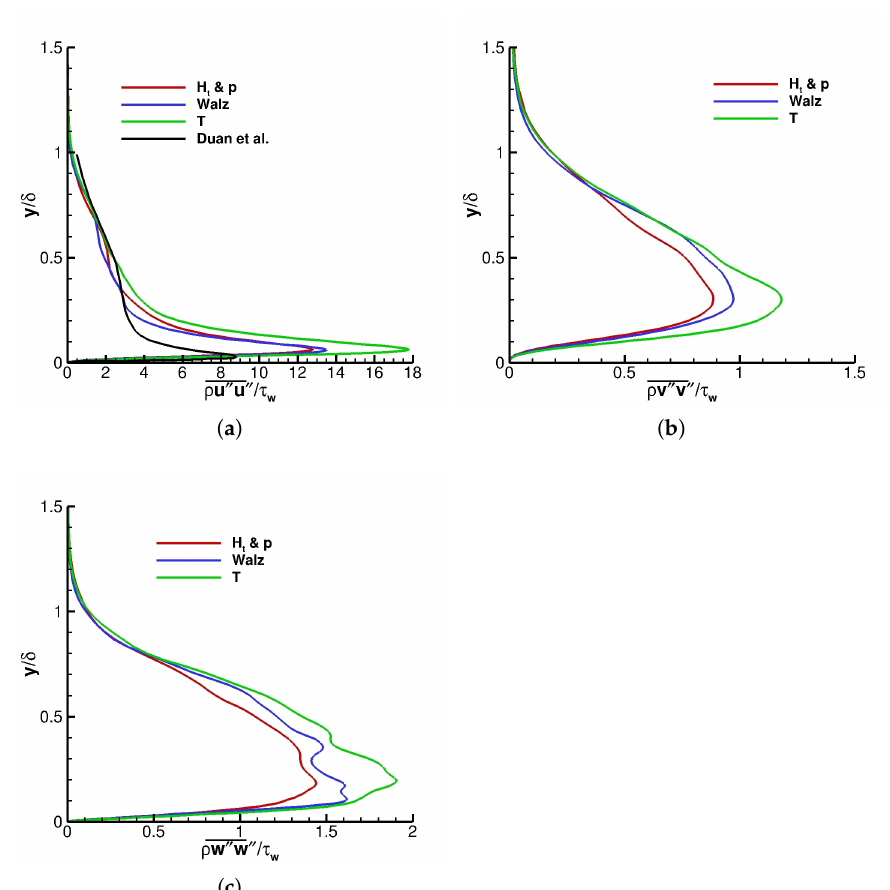
Figure 7. Effect of recycling-rescaling method on Morkovin scaled dimensionless turbulent normal stresses of condition No. 2 at x / δ = 20 for: ( a ) Streamwise direction. ( b ) Wall normal direction. ( c ) Spanwise